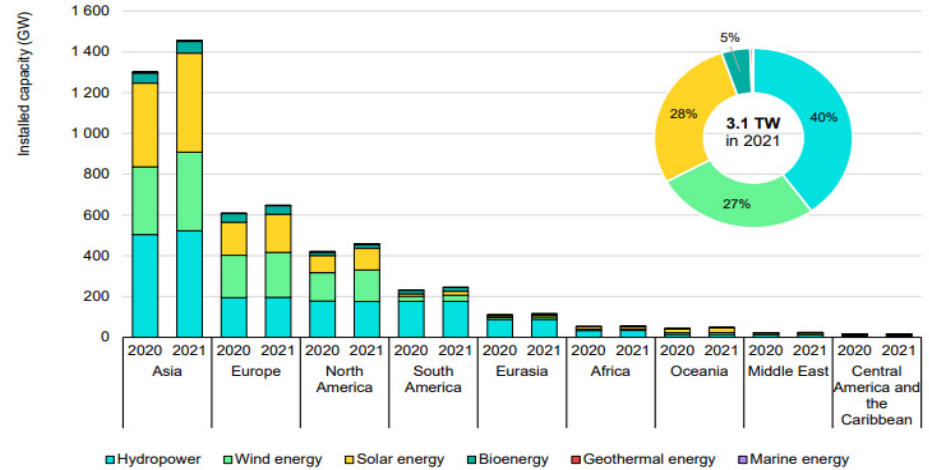
Figure 1. Renewable generation capacity by region and technology, 2020–21(IEA, 2021a).